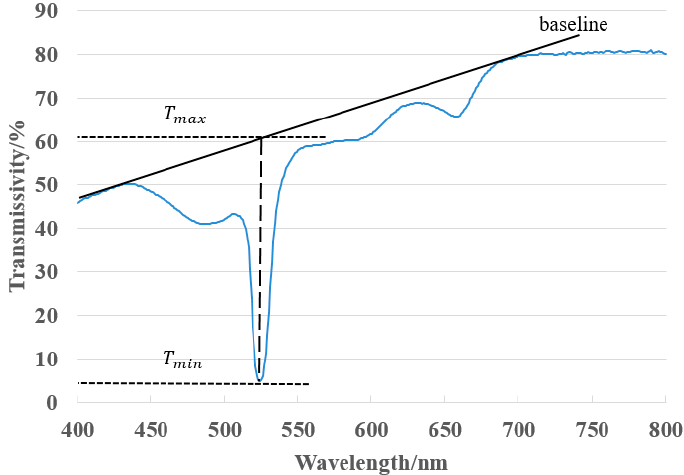
Figure 5. The transmission spectrum of the Litiholo holographic material after